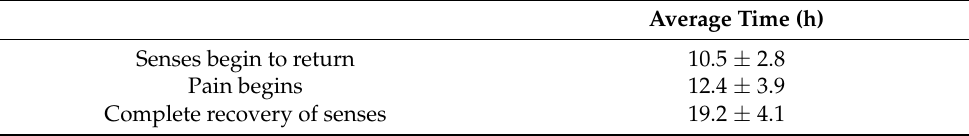
Table 3. Results of sensory recovery over time after surgery in Group B.